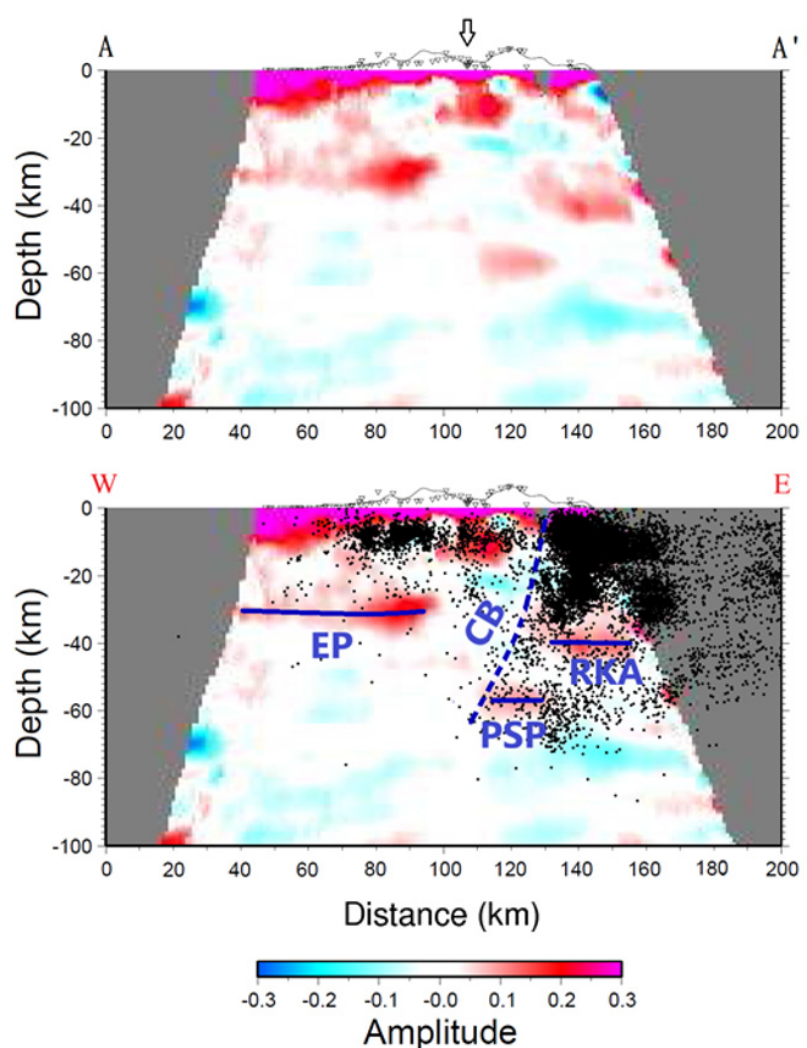
Figure 5. The CCP stack of receiver functions along the A-A ′ profile. The topography along the A-A ′ profile is shown at the top of the figure. The triangles represent the locations of seismic stations which are projected to the A-A ′ profile and the arrow indicates the cross point of profiles A-A ′ and B-B’. The top figure is the CCP stack of receiver functions along the profile. The bottom figure is the interpretation of the top figure and incorporated with the earthquakes relocated by Wu et al. [29] for magnitude (ML) ≥ 3.0 in the past 15 years. The blue dashed line represents the collision boundary “CB” between the Philippine Sea Plate and the Eurasian Plate. The blue lines indicate the Moho discontinuities of the Eurasian Plate (EP), Philippine Sea Plate (PSP) and Ryukyu arc (RKA).